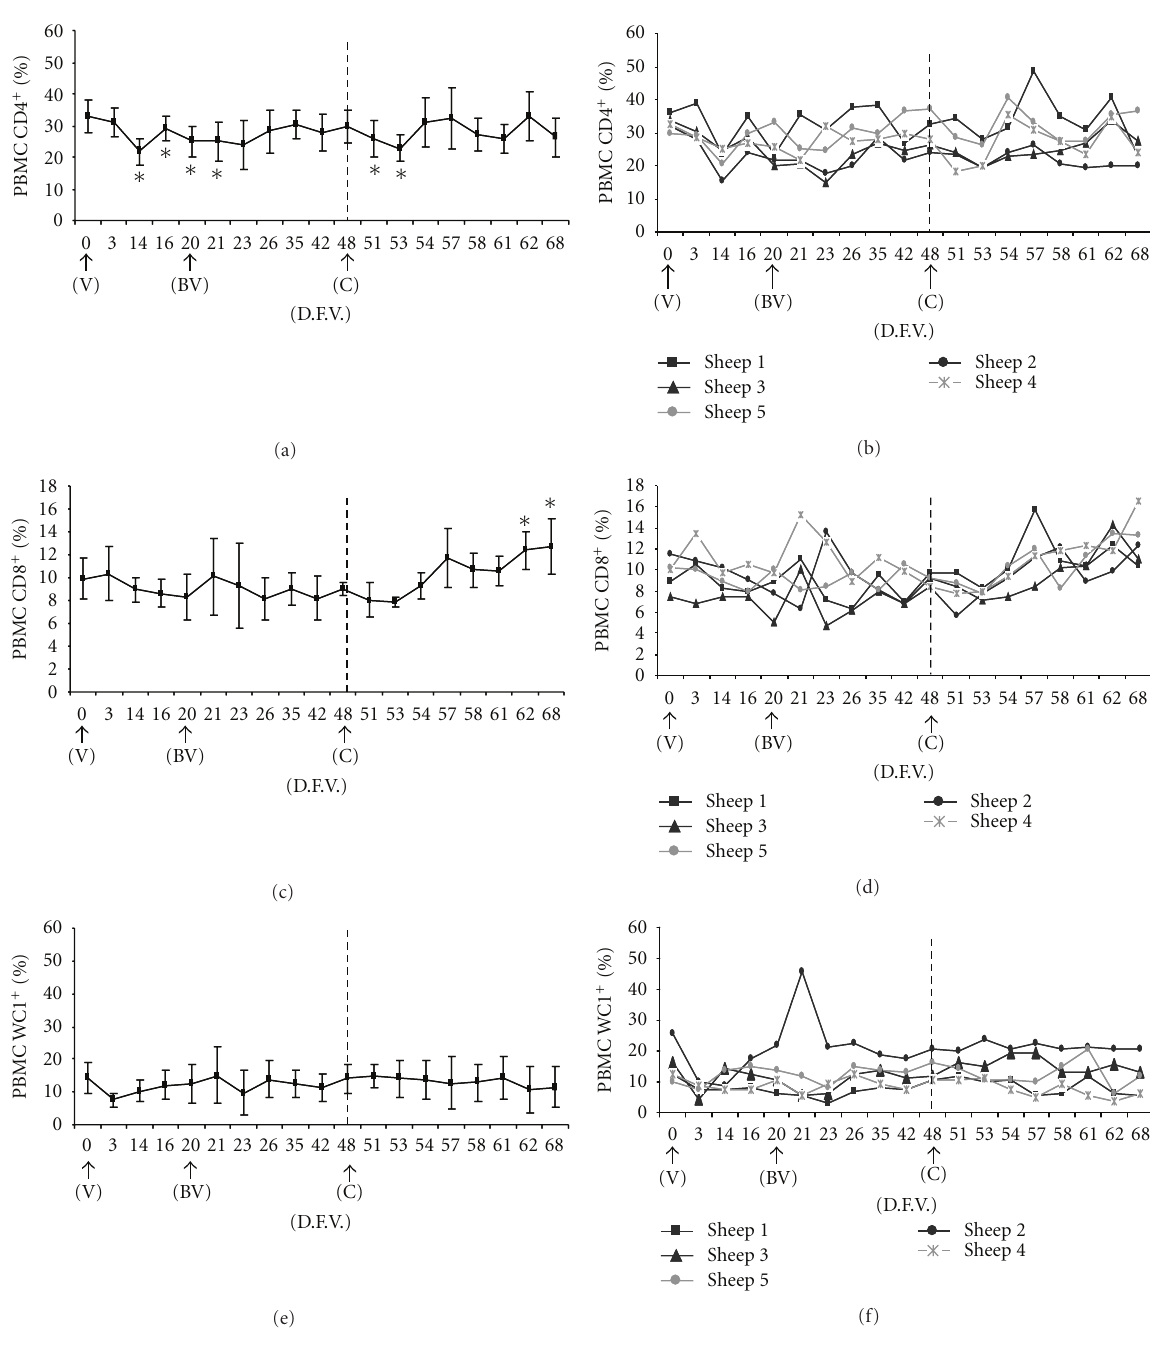
Figure 2: Mean percentages ( ± SD) and individual percentages of PBMC populations labeled by antibodies against CD4 + (a, b), CD8 + (c, d), and WC1 + (e, f) throughout the experiment. ∗ is statistically significant di ff erence ( P ≤ 0.05) from prevaccination value on day 0, based on ANOVA with the Huynh-Feldt correction. Abbreviations: V, day of first vaccination; DFV, day after first vaccination; BV, day of boost vaccination; C, day of